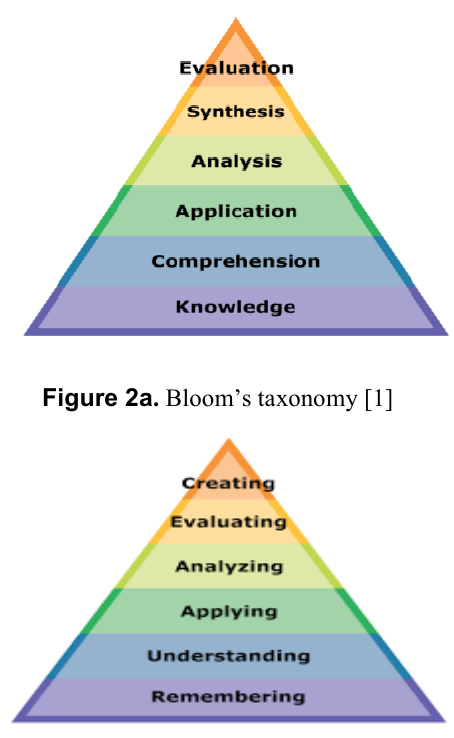
Figure 2b. Modified Bloom’s taxonomy